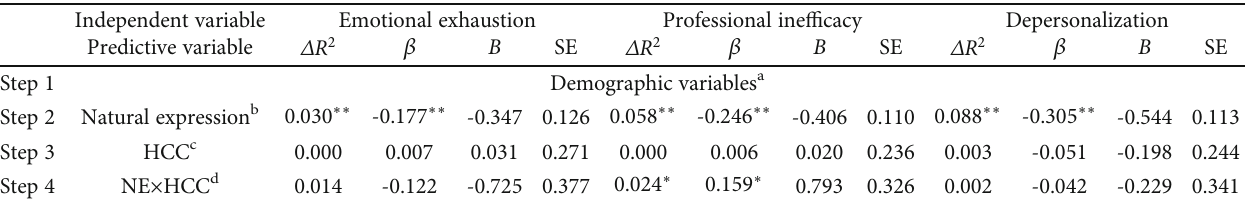
Table 6: Coe ffi cients of multiple linear regression of expression of naturally felt emotions, hair cortisol content, and their interaction against Maslach job burnout ( n = 229 ).